Question: Does the plotted quantity increase or decrease?
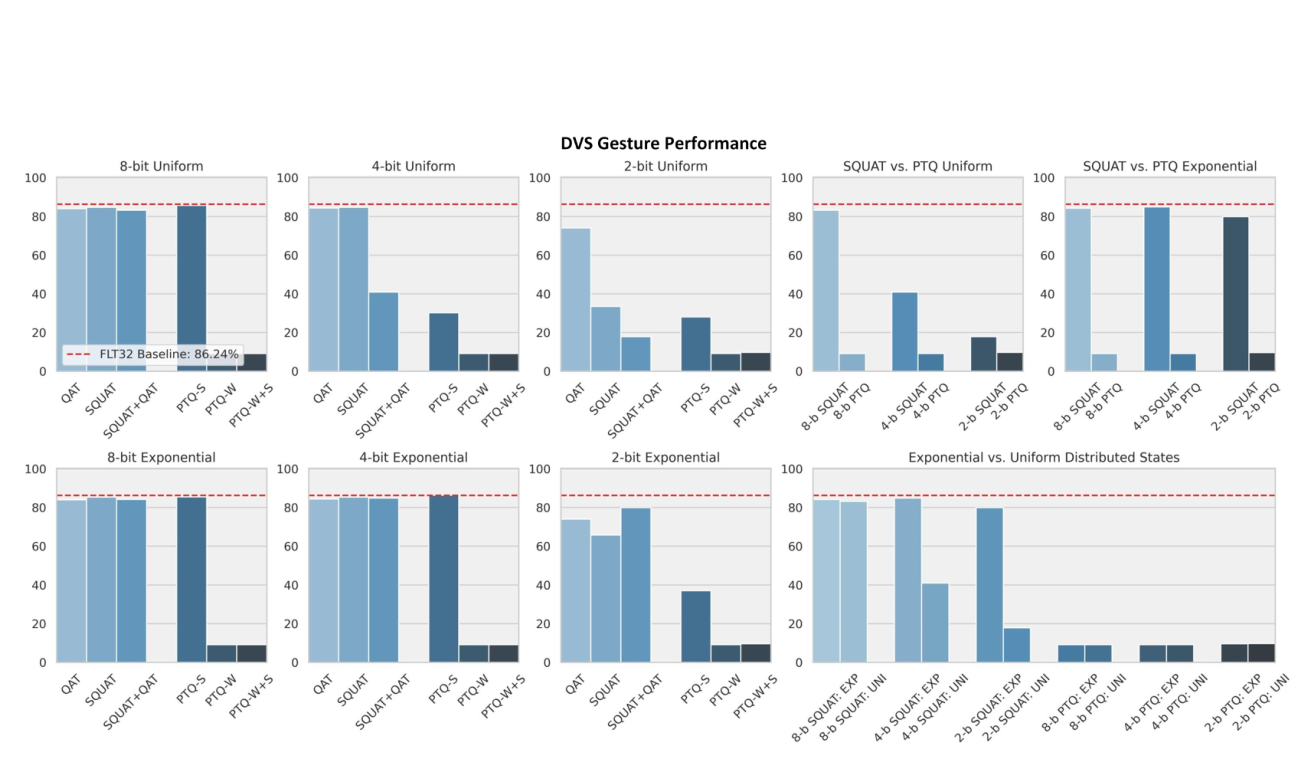
Answer: increasing